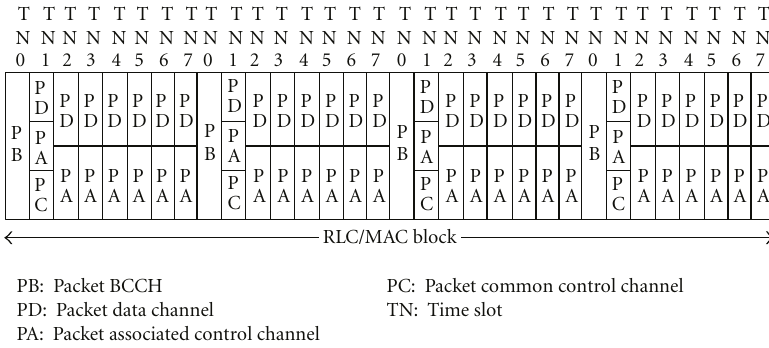
Figure 10: Possible configuration of a GPRS downlink radio channel.